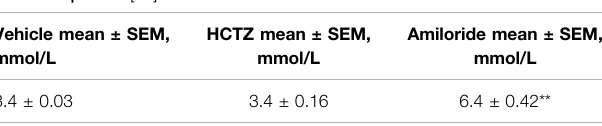
TABLE 2 | Blood [K +